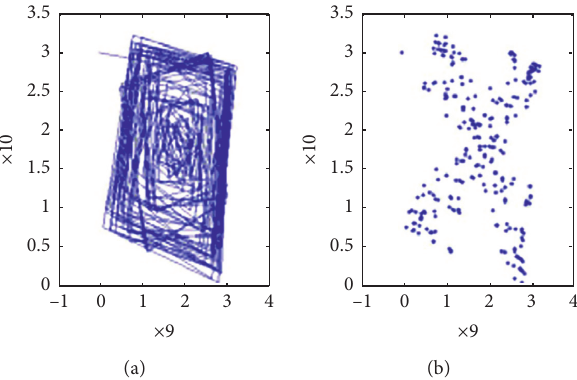
Figure 10: ω � 232 without random perturbation. (a) Phase trajectories. (b) Poincare maps.